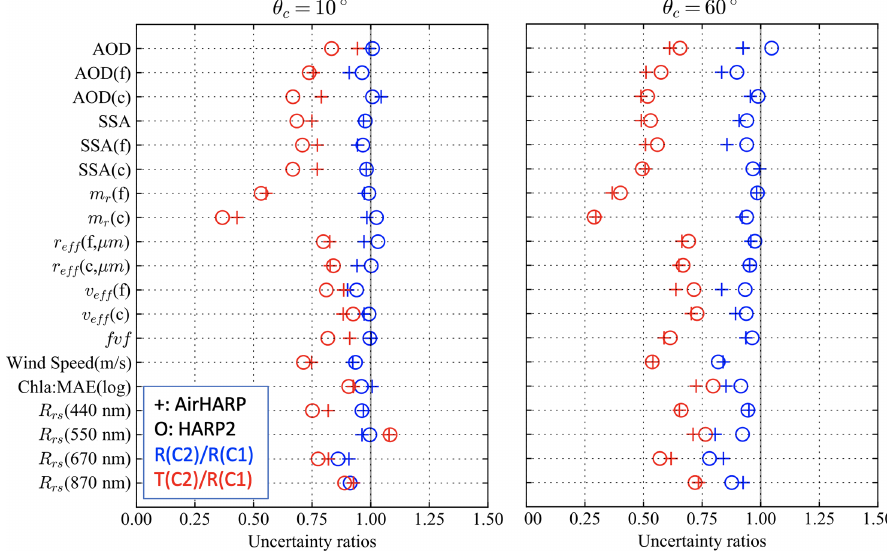
Figure 9. Similar to Fig. 8 but for the scenarios of C1 and C2 when correlations are only in reflectance